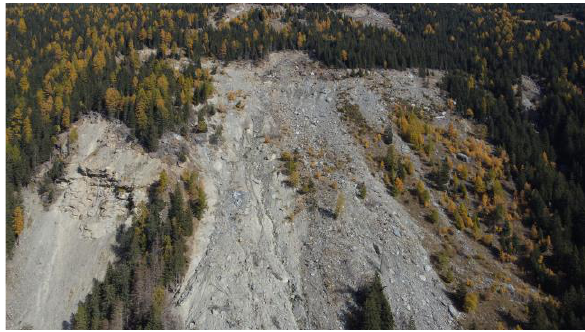
Figure 1. Ruinon landslide, lower